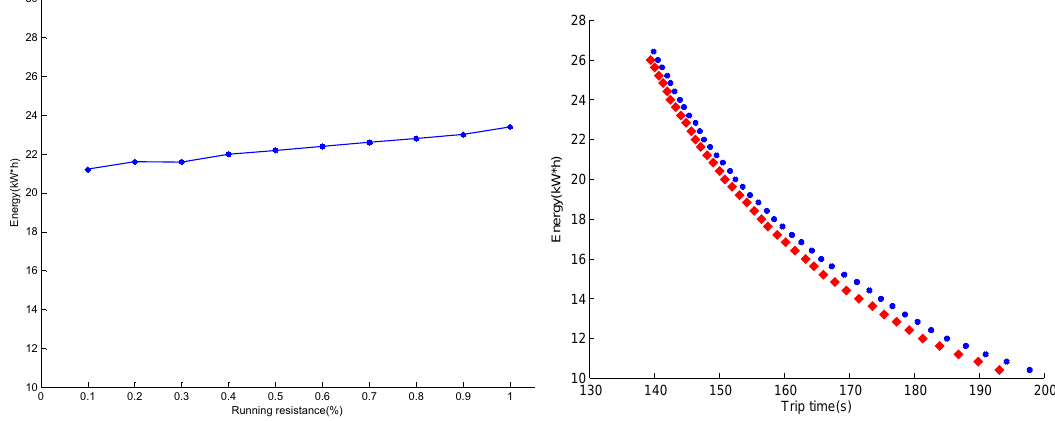
Figure 11. Influence of running resistance on the traction energy